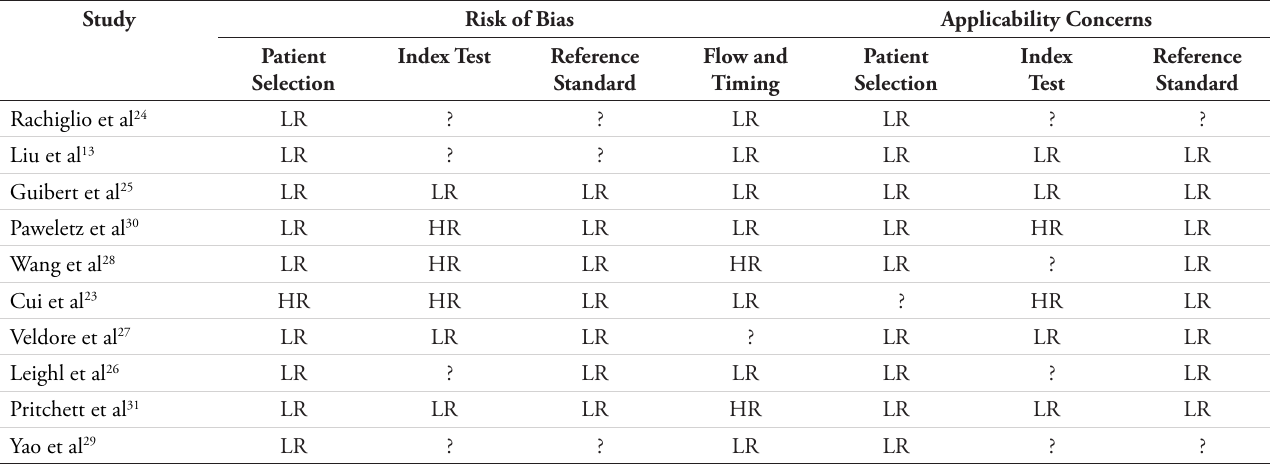
Table 2. Included Articles Quality Assessment According to QUADAS-2